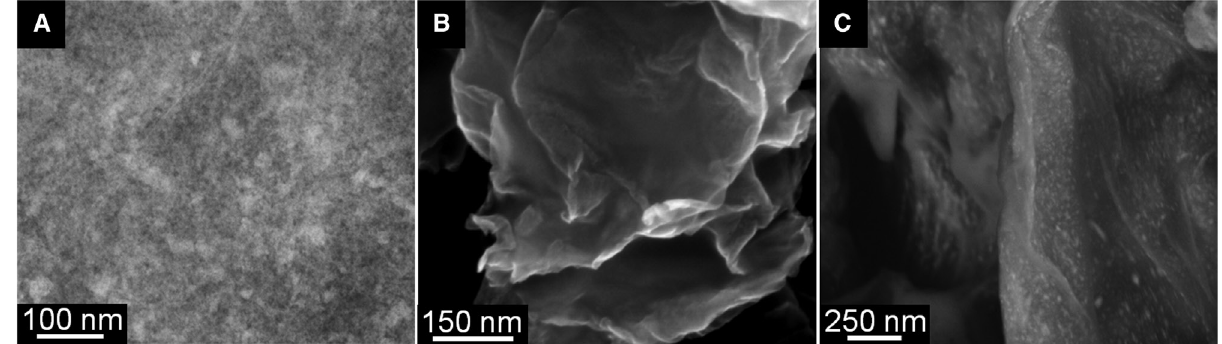
Figure 1: Scanning transmission electron microscope (STEM) images of heat-treated GO-supported antimony oxides: GO-Sb-80 (A), rGO-Sb- 300 (B) and rGO-Sb-650 (C) in backscattering electron mode.